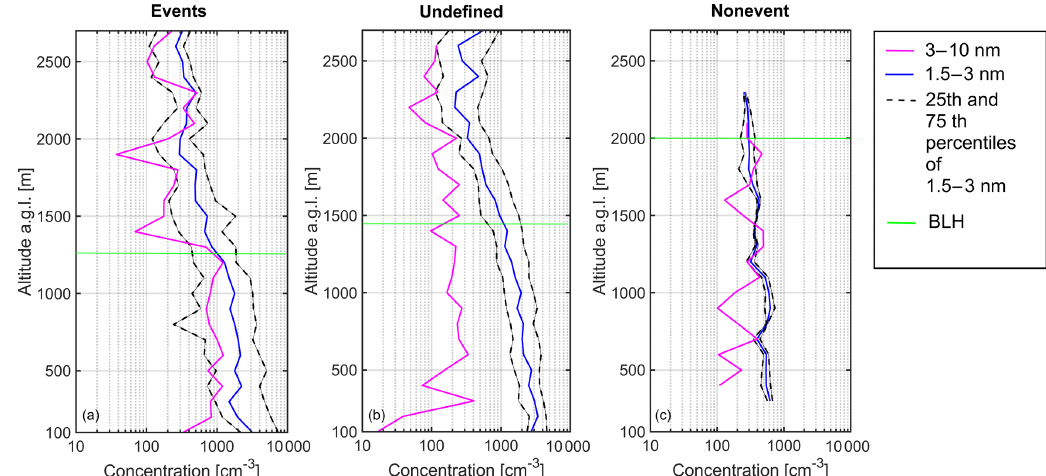
Figure 2. All-day median particle concentrations in two size ranges, 3–10nm (pink) and 1.5–3nm (blue), and 25th and 75th percentiles (dashed lines) of the 1.5–3nm particle concentration as a function of altitude for afternoon profiles over 17 event days (a) , 34 undefined days (b) and 2 non-event days (c) . The concentrations were calculated from the differences between three instruments (PSM, uCPC and SMPS) at different cut-off sizes: 1.5, 3 and 10nm, respectively. The data were collected from near ( < 30km) SMEAR II during spring and August flight measurement campaigns in 2015 and a spring campaign in 2017. Median boundary layer heights are marked by green